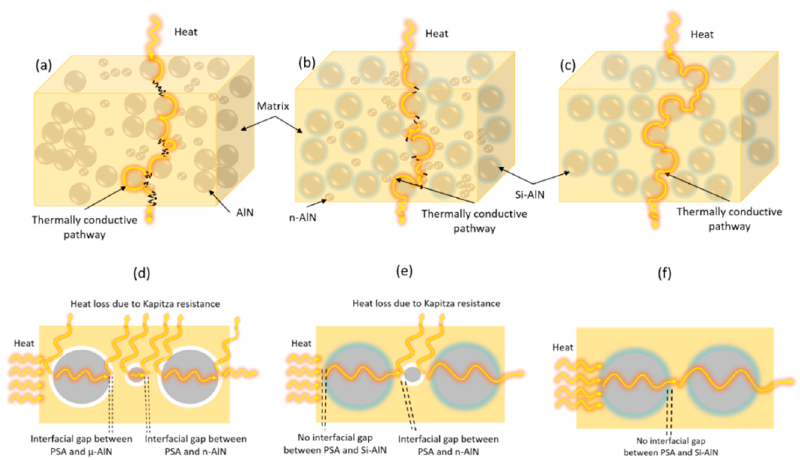
Figure 7. Schematic representation of the heat conduction path in different PSA composites: ( a , d ) µ-AlN/n-AlN/PSA, ( b , e ) Si-µ-AlN/n-AlN/PSA, and ( c , f ) Si-µ-AlN/PSA, respectively.